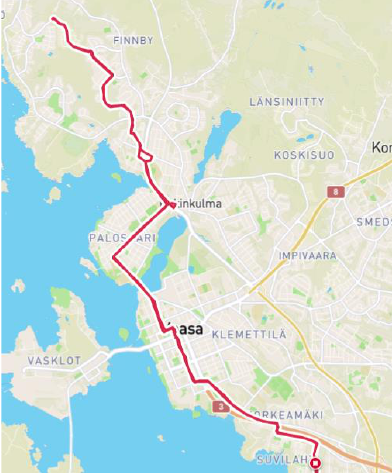
Figure 2. Driving circuit.